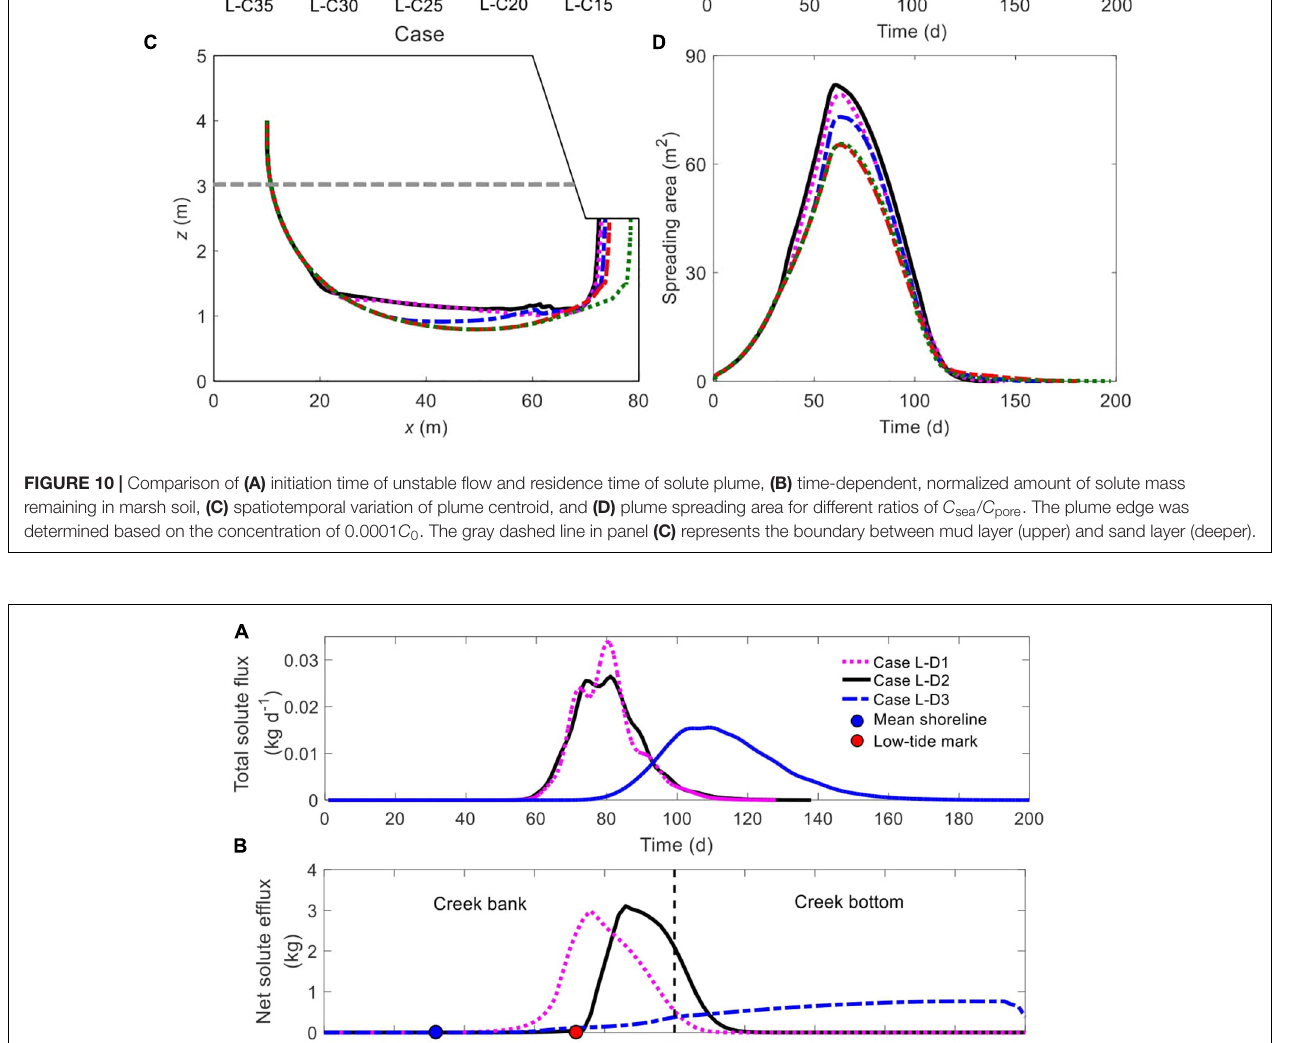
Frontiers in Marine Science |